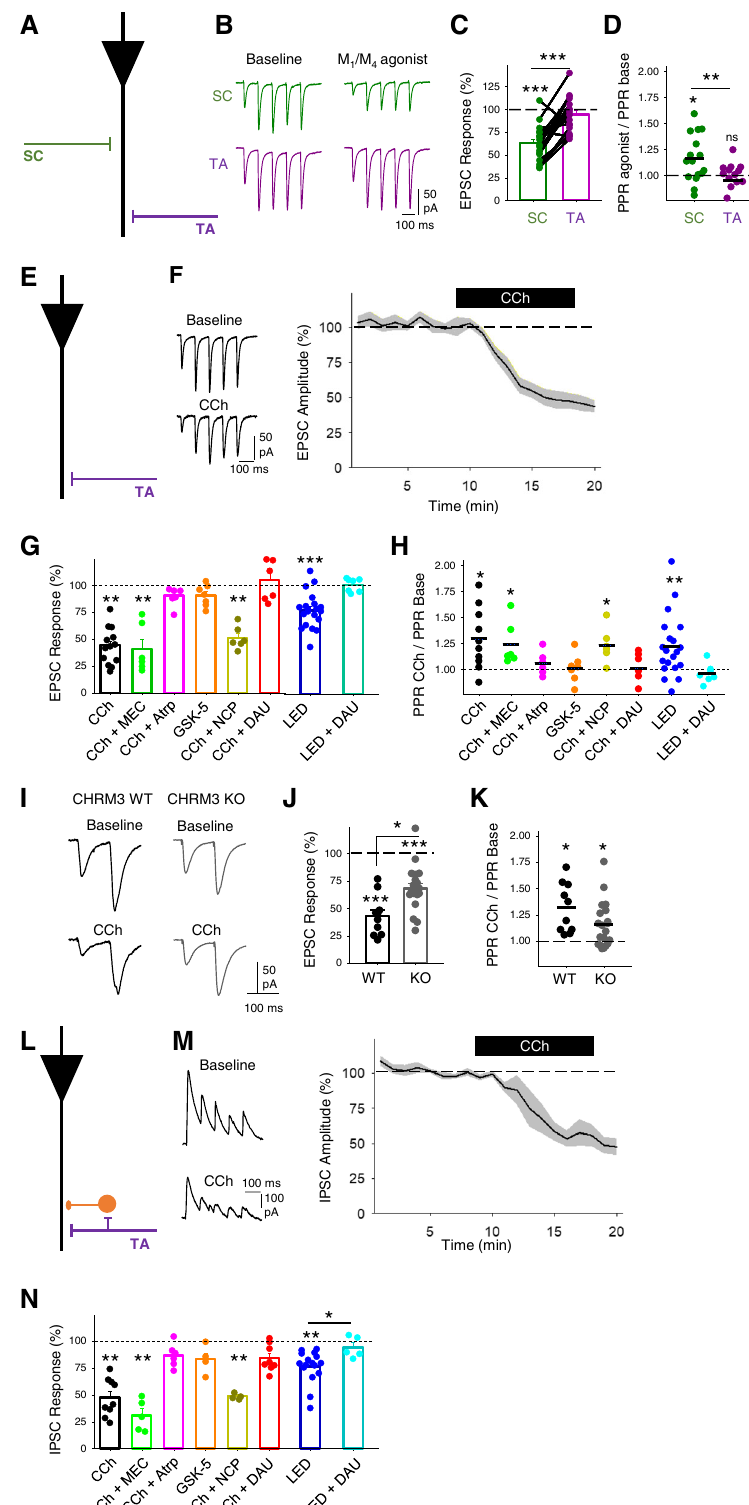
GABA B receptors. To explore the location of M 3 receptors we performed three additional sets of experiments to test whether M 3 receptors located on pyramidal cells or interneurons in CA1 31,32 regulate presynaptic neurotransmitter release. The fi rst experi- ment blocked post-synaptic M 3 receptor function by the inclusion of GDP- β -S in the patch pipette. This prevented the